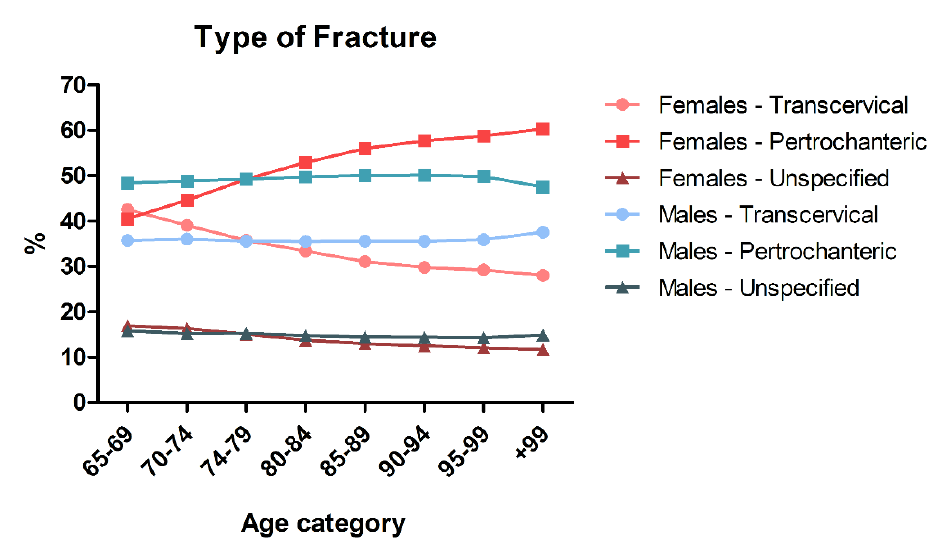
Figure 3. Relative frequency of types of fracture in males and females in different age categories.